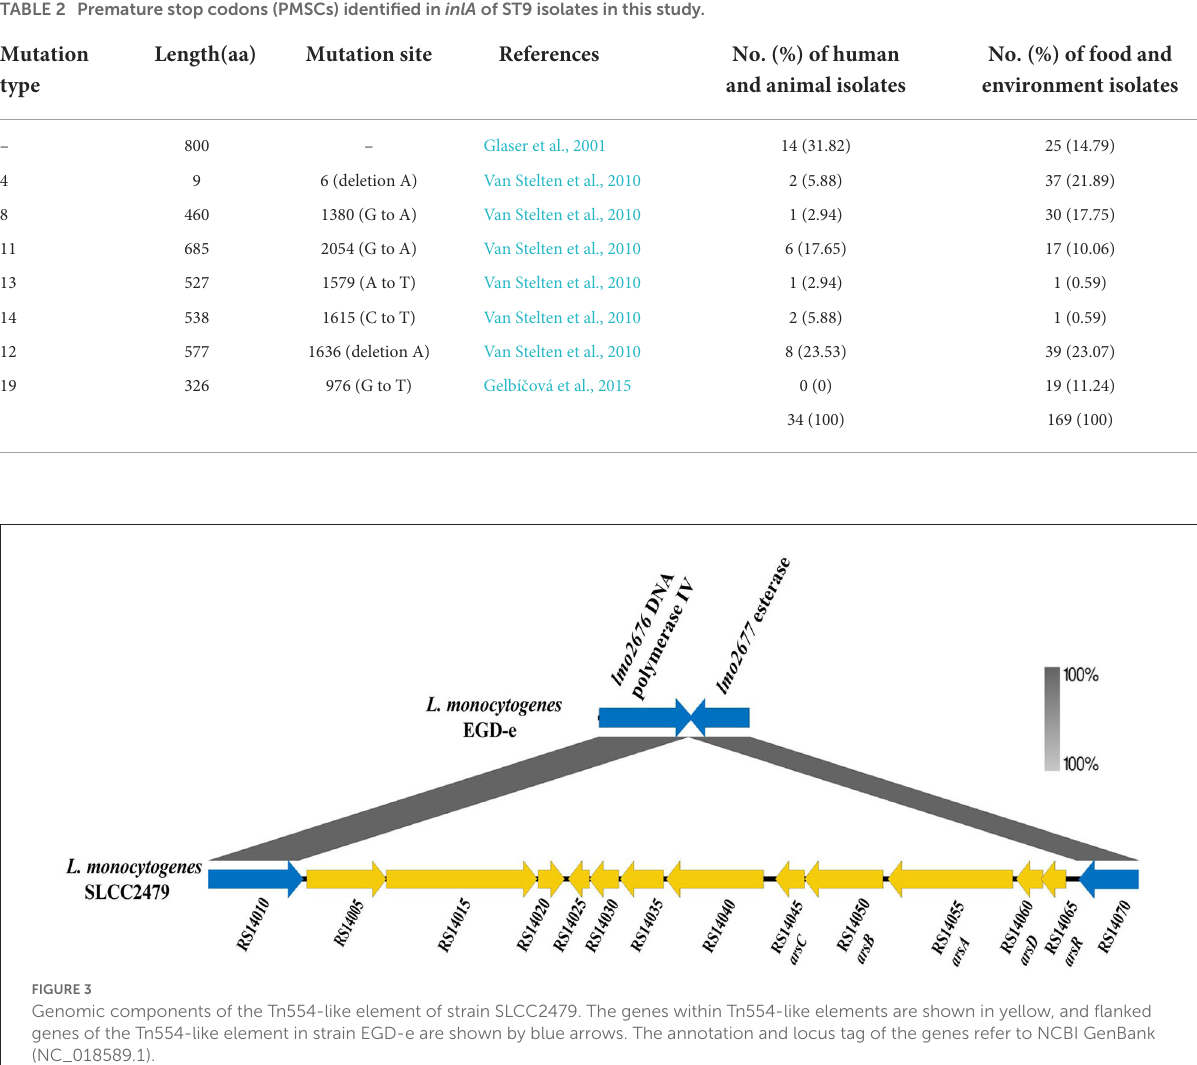
TABLE 2 Premature stop codons (PMSCs) identified in inlA of ST9 isolates in this study.